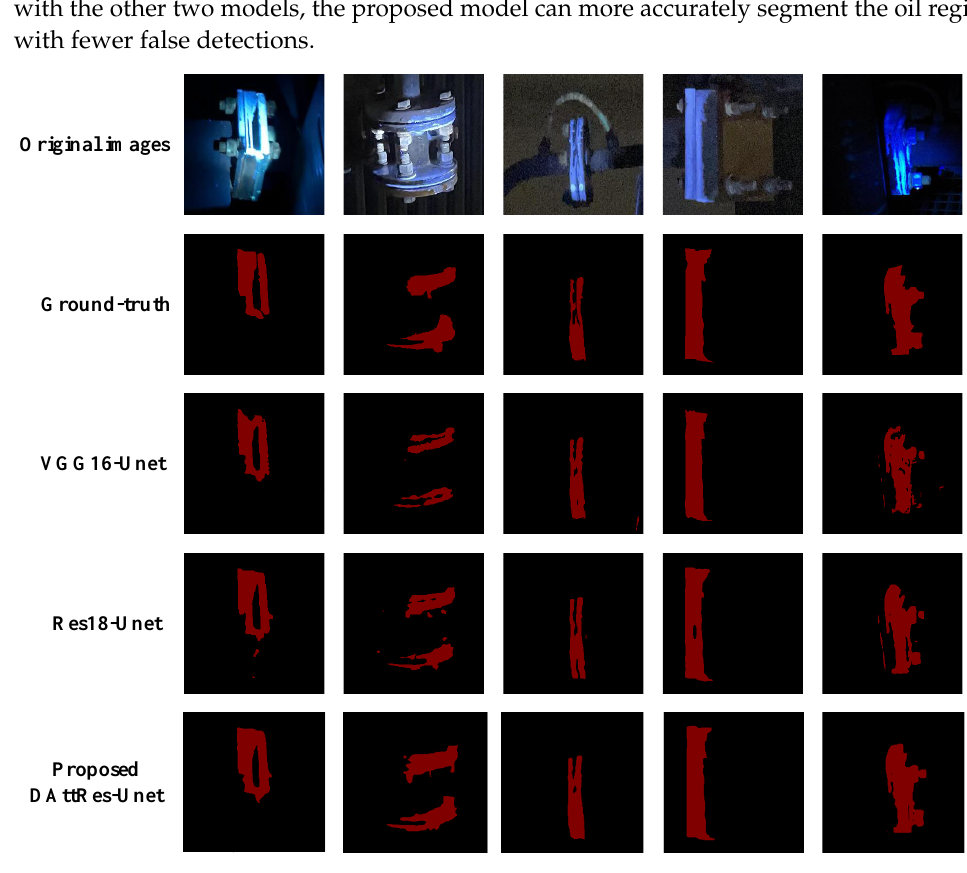
Figure 9. The segmented results of VGG16-Unet, Res-Unet, and the proposed